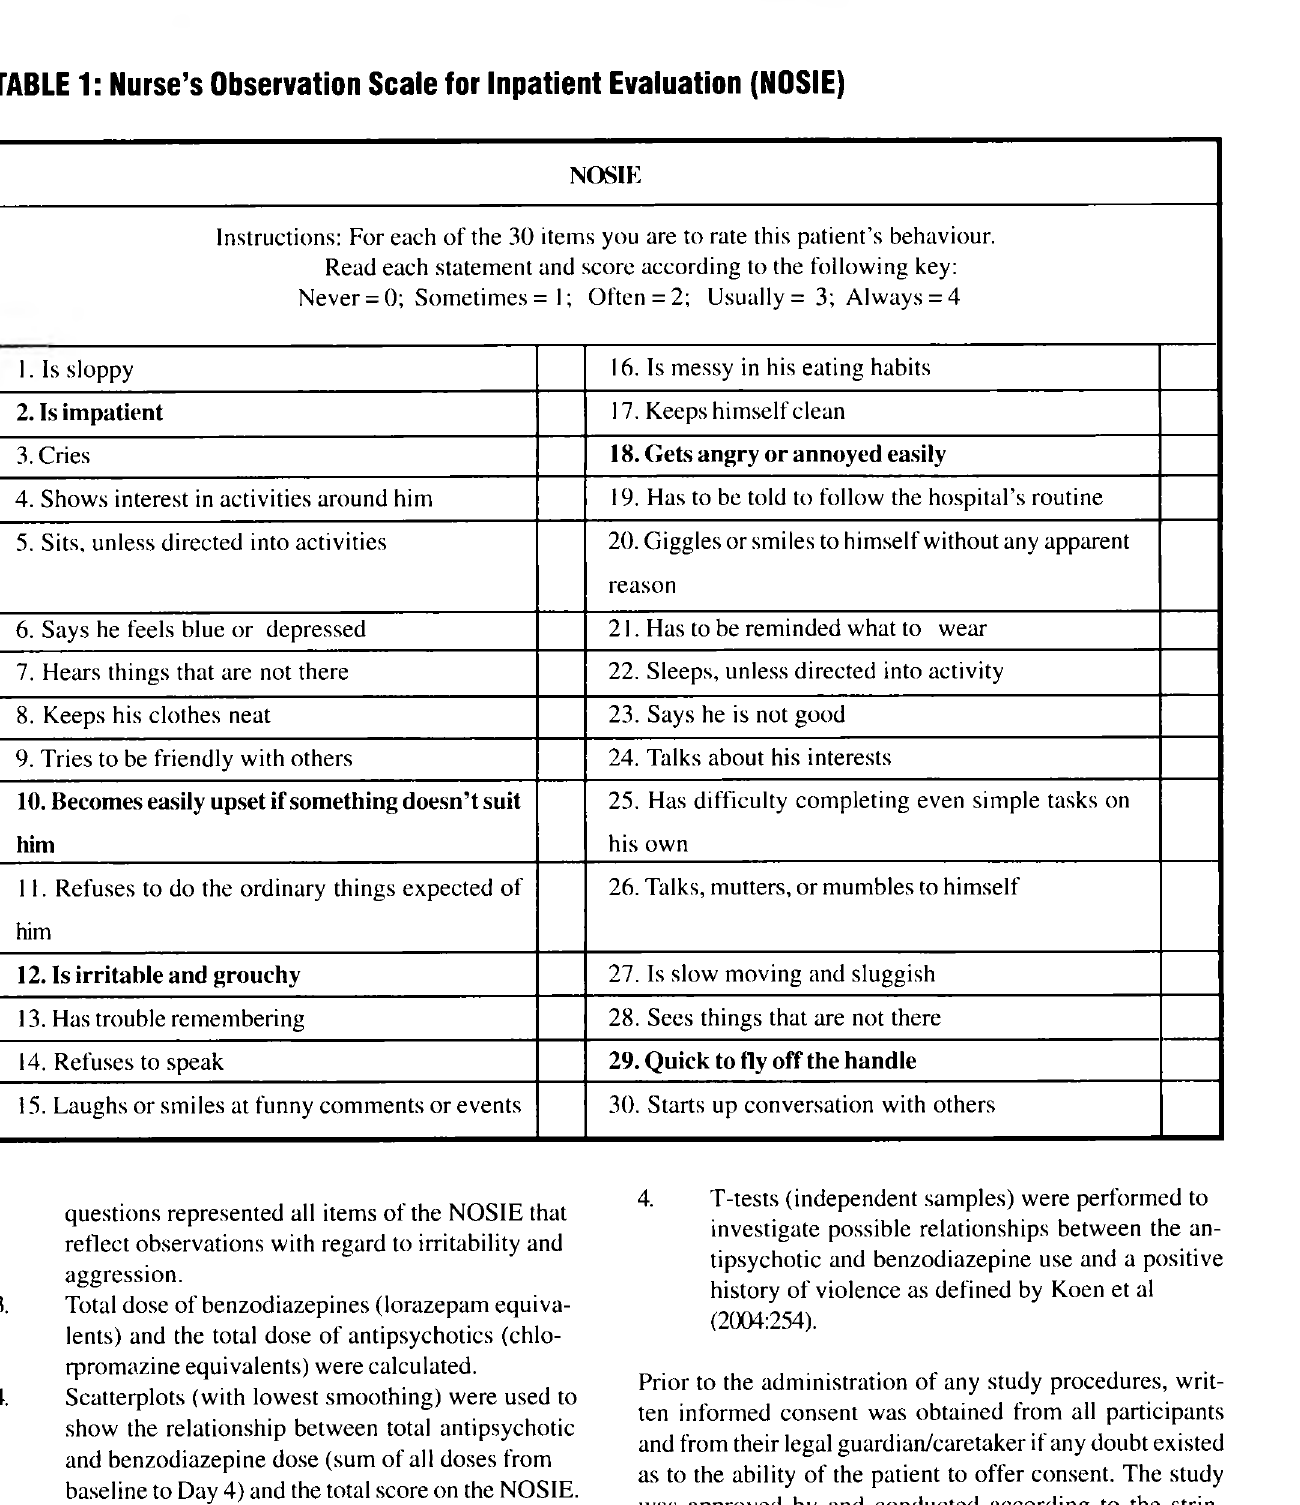
TAB LE 1 : Nurse’s Observation Scale for Inpatient Evaluation (NOSIE)